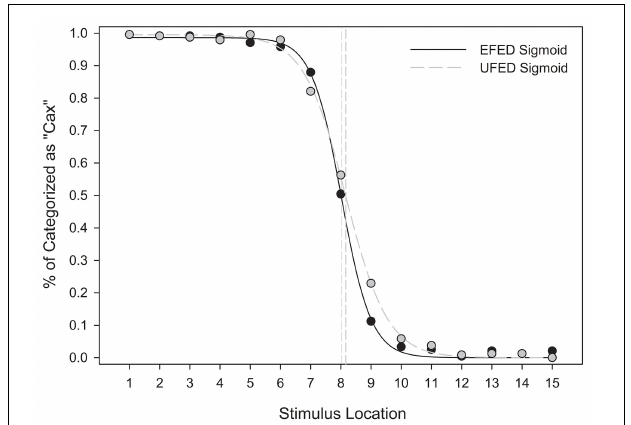
FIGURE 6 | Test categorization response accuracy in equal frequency (EFED) and unequal frequency conditions (UFED). Stimulus values correspond to stimuli selected from the entire stimulus range (i.e., stimuli 1–15). Error bars represent 1 standard error of the mean ( N = 60).